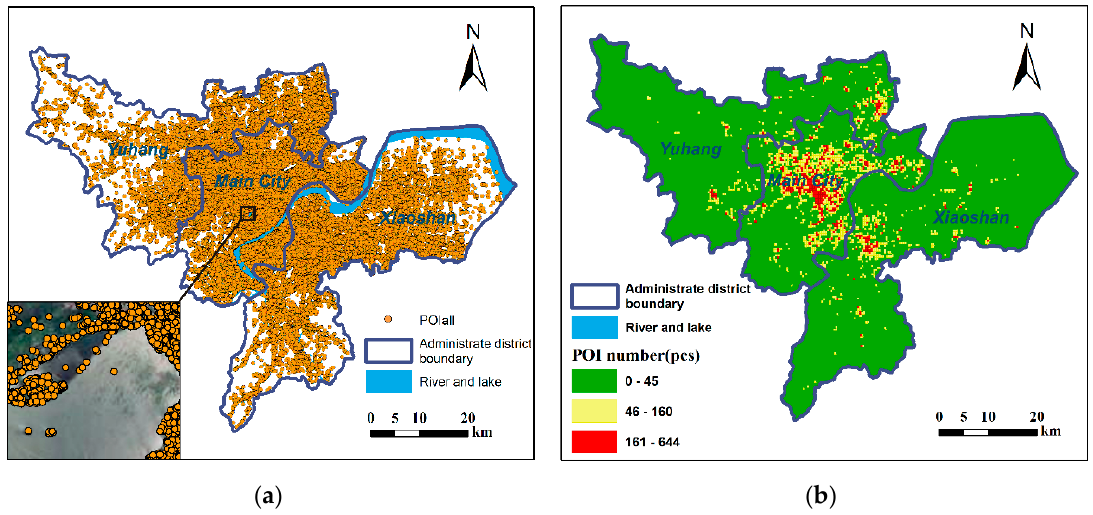
Figure 2. Point of interest (POI) data of Hangzhou in May 2018: ( a ) Spatial distribution of POI, each point stands for one point of interest. ( b ) Gridded map of POI number with 500 m resolution, representing the number of POI in a square of 25 ha.